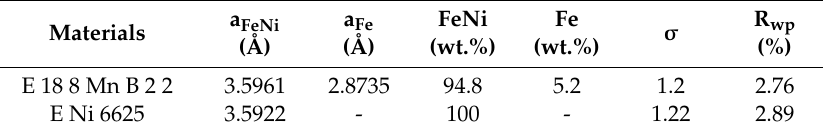
Table 6. Parameters from refining diffraction spectra.